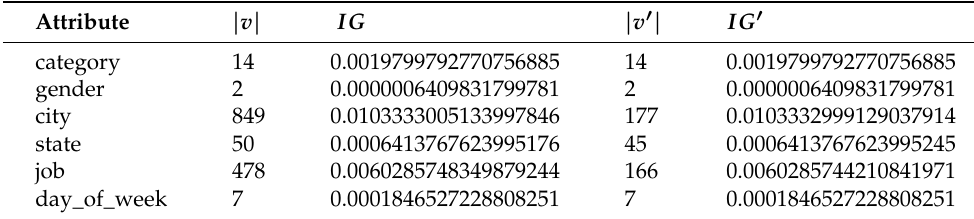
Table 13. The categorical attributes and their IG for Dataset 3.